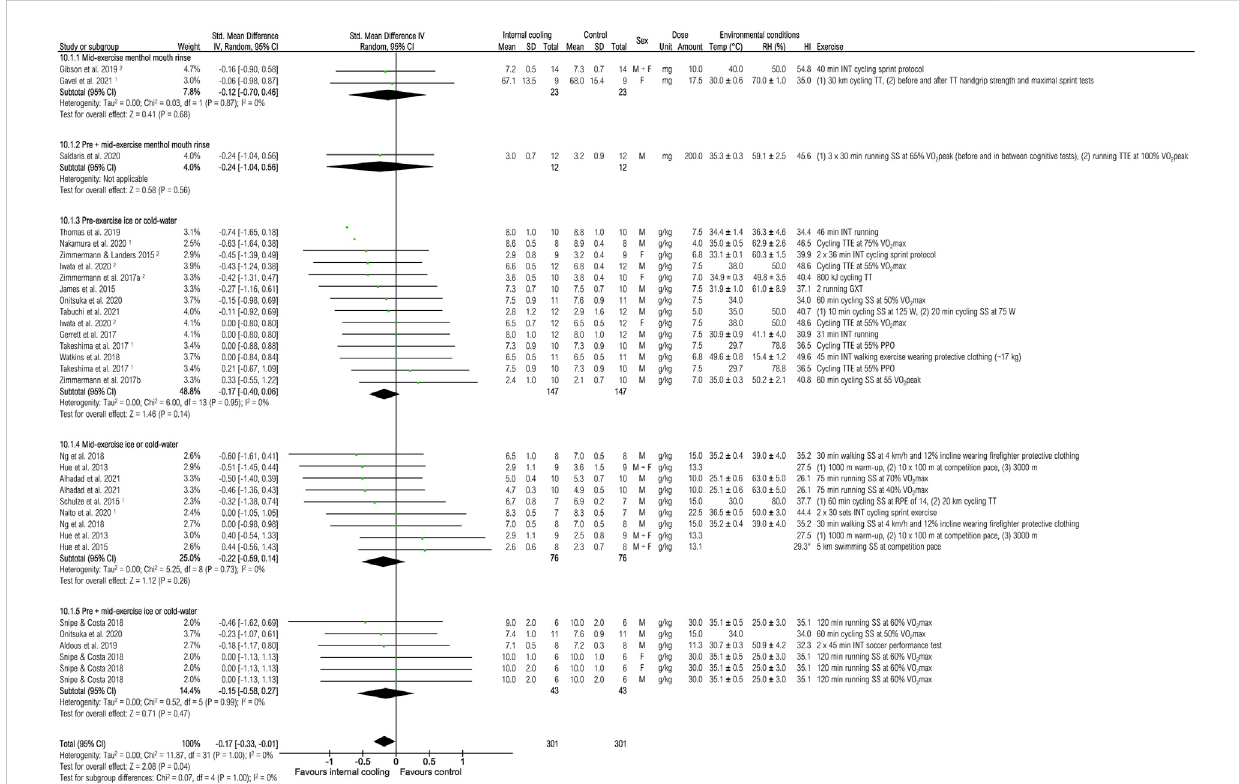
FIGURE 11 Meta-analysis of standardized mean difference in thermal sensation with 95% CI between internal cooling and control. 1 Studies with signi fi cant positive performance effects of internal cooling. 2 Studies with no performance effects of internal cooling. F, female; GXT, graded exercise test; HI, heat index; INT, intermittent exercise; M, male; PPO, peak power output; RH, relative humidity; RPE, rate of perceived exertion; SS, steady-state exercise;